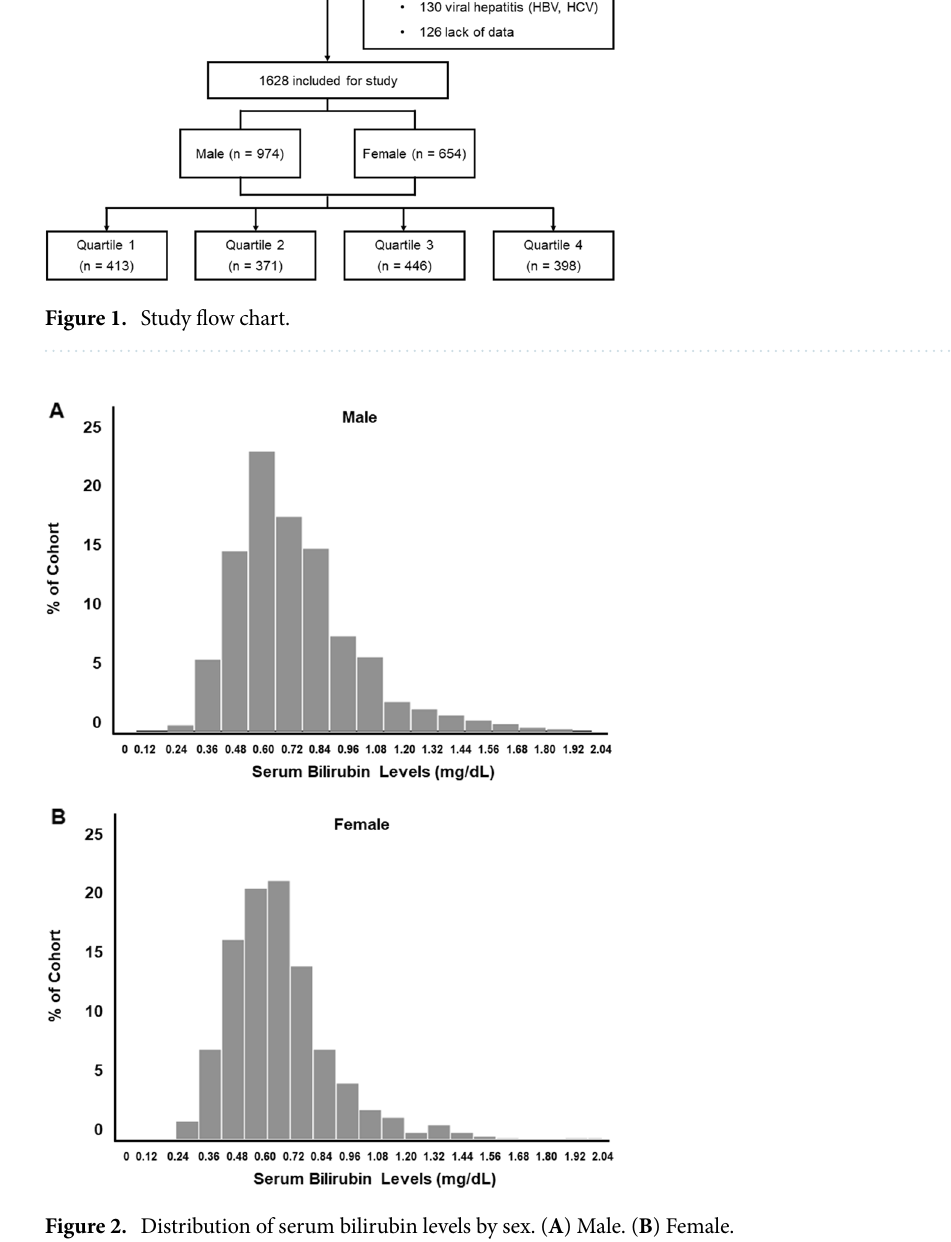
Figure 2. Distribution of serum bilirubin levels by sex. ( A ) Male. ( B )